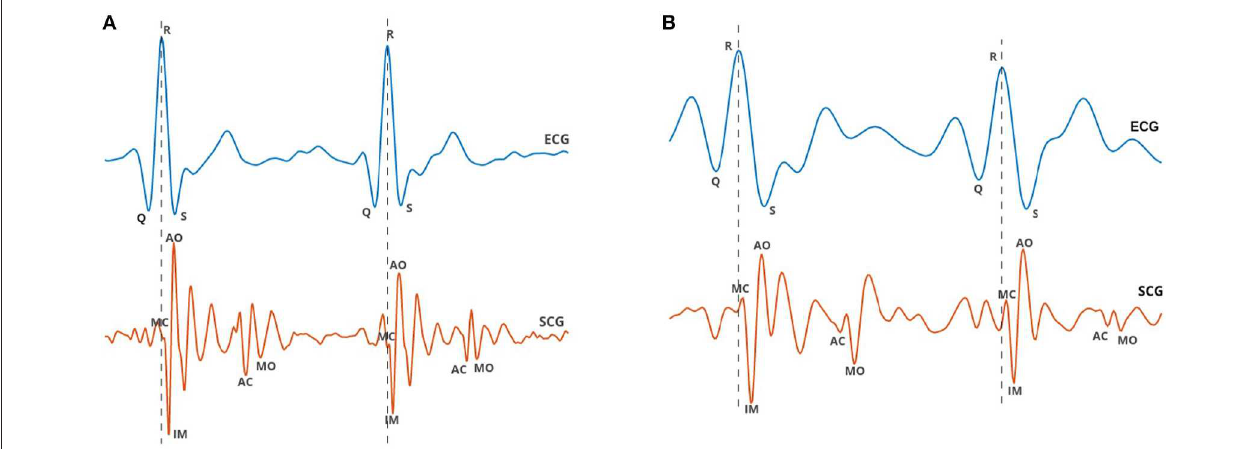
FIGURE 2 | ECG and SCG signals were simultaneously recorded from a 67-year-old male participant with two arteries occluded more than 50%: (A) during rest and (B) immediately after exercise. Characteristic points of SCG labeled as MC, IM, AO, AC, and MO coincide with mitral valve closure, isovolumic contraction, aortic valve opening, aortic valve closure, and mitral valve opening,